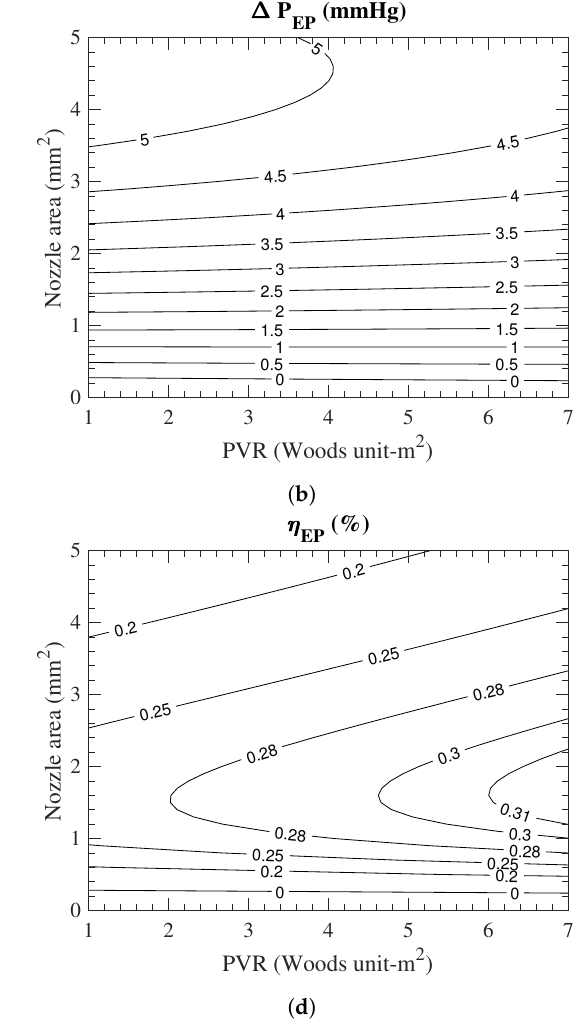
Figure 13. ( a ) The PA pressure, ( b ) the ejector pump pressure recovery, ( c ) the SVC pressure, and ( d ) the ejector pump efficiency as functions of the nozzle area and the PVR. The dashed line in ( c ) represent the optimal nozzle area that produces the lowest SVC pressure at a given PVR. These results are obtained from the algebraic